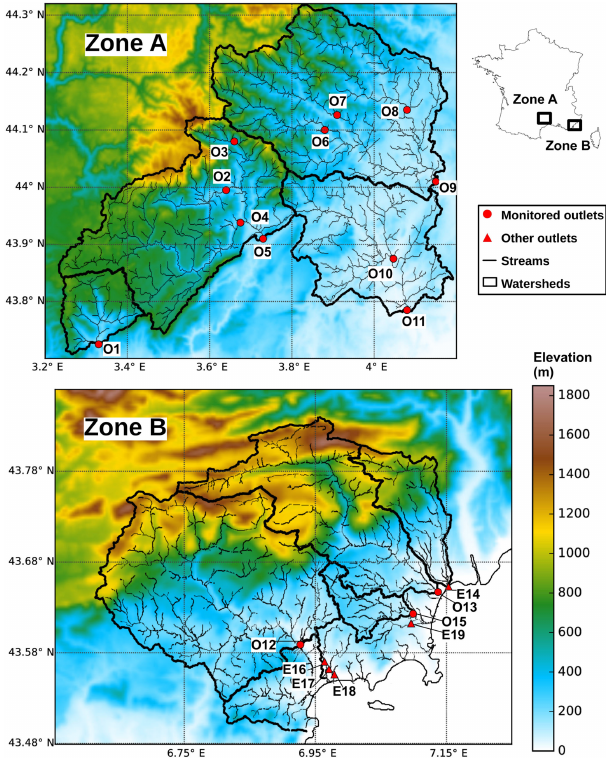
Figure 1. Location of the study areas, zones A and B, and bound- aries of the main watersheds of both areas. The red markers cor- respond to the studied outlets. The circular outlets are monitored. Coordinates are in WGS84. The elevation was obtained from the SRTM